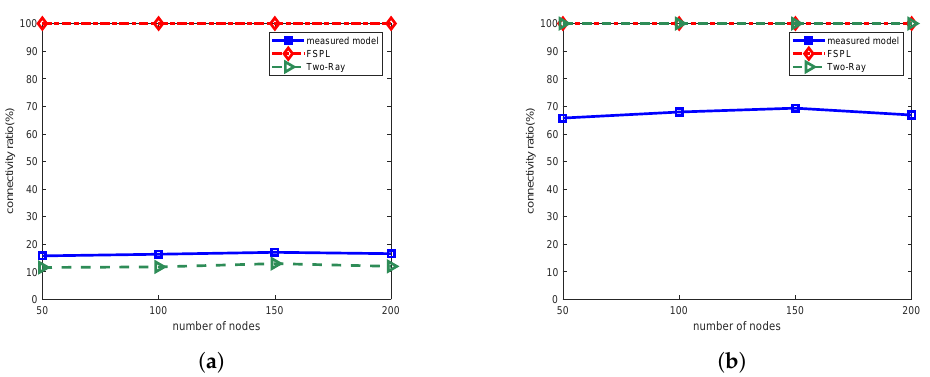
Figure 10. Average percentage of connectivity: ( a ) H t = H r = 5 cm; and ( b ) H t = H r = 1